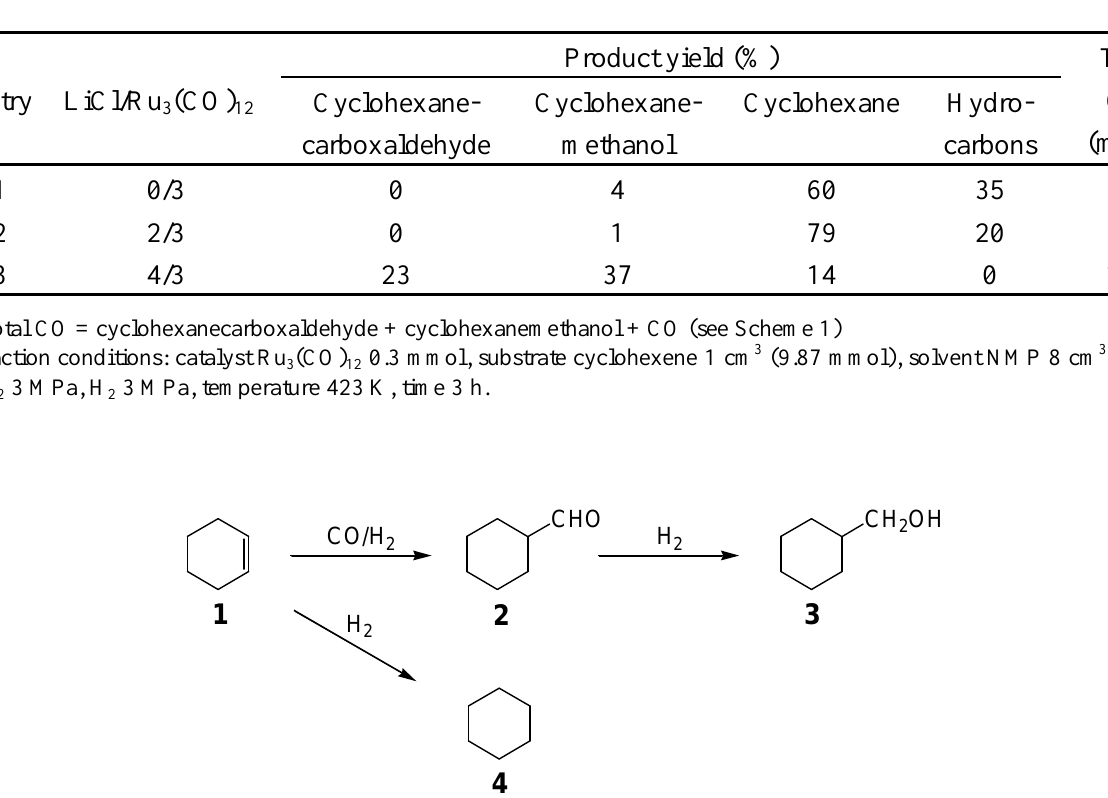
with CO and H using Ru (CO) 2 2 3 12